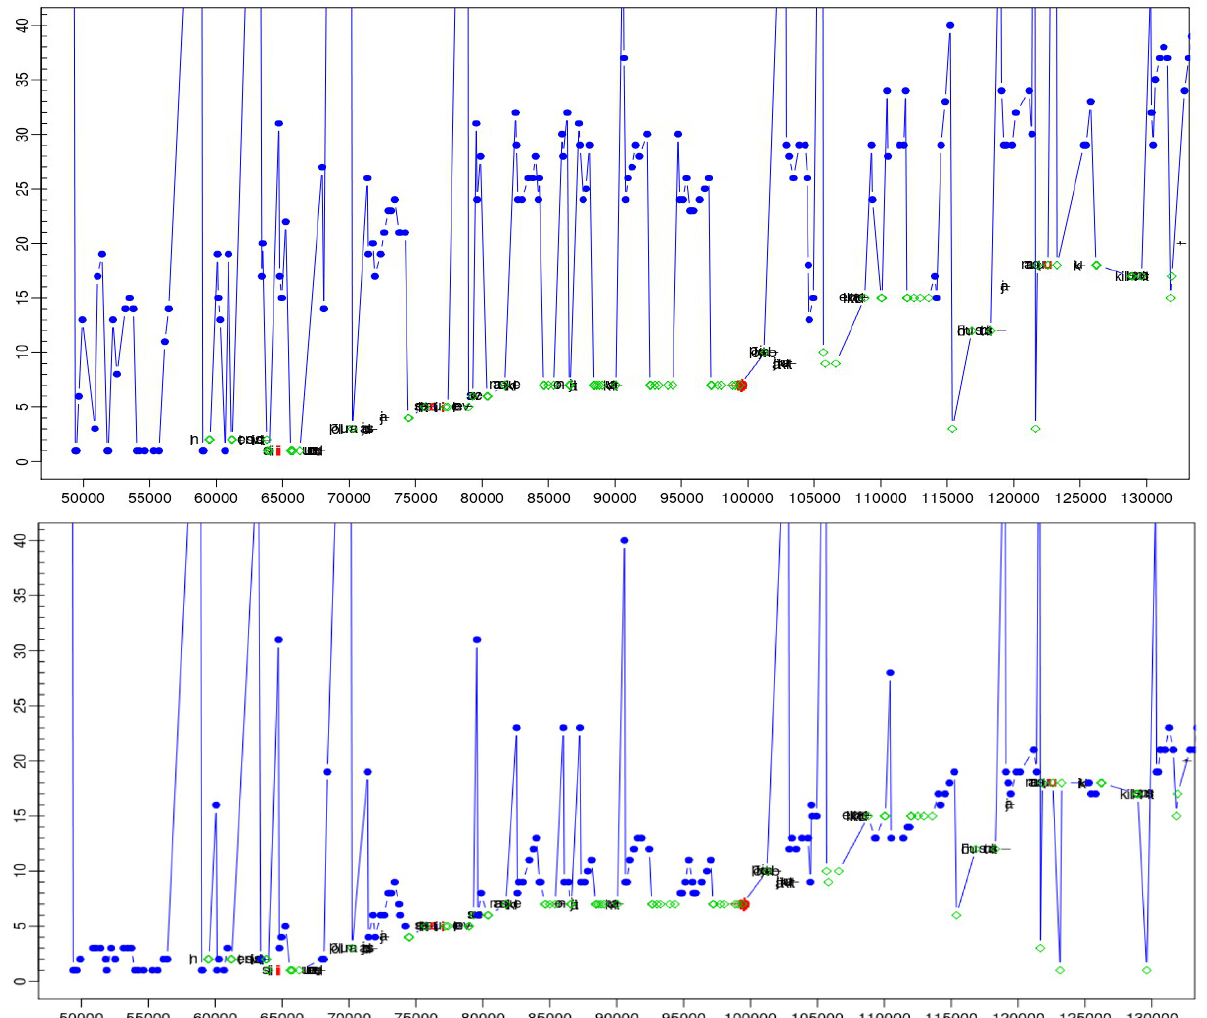
Figur 5a (top) naïve mapping vs. its re-mapped version 4b (bottom). Both figures represent the same translation segment.